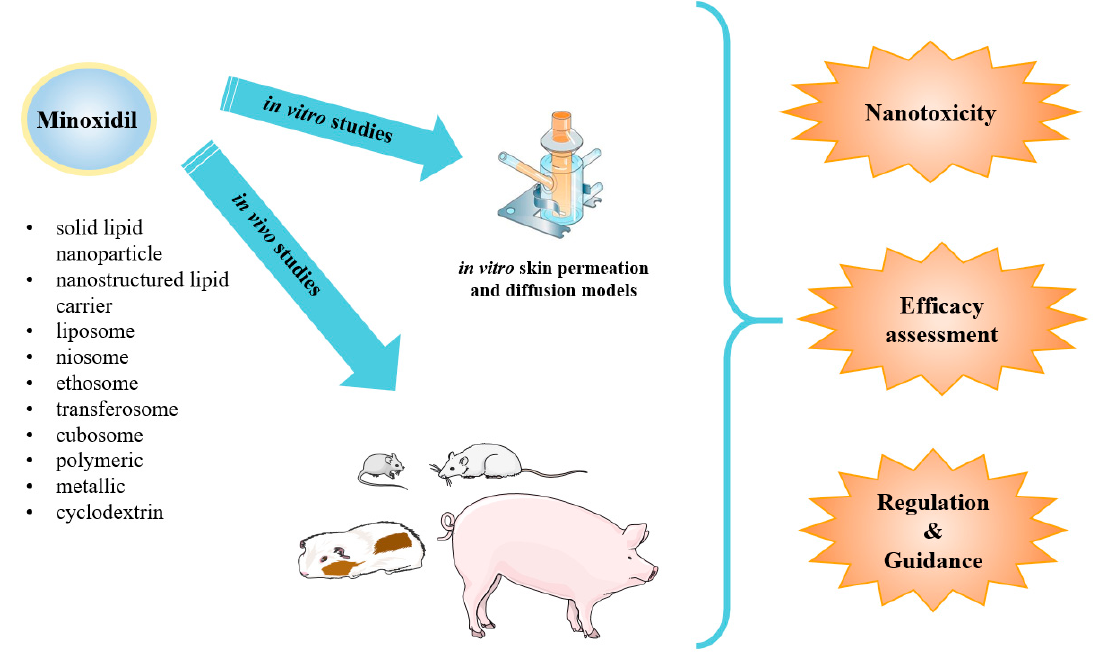
Figure 2. Schematic presentation of minoxidil nanoparticle types applied as topical drug delivery systems for androgenic alopecia developed so far. Such systems have been submitted to in vitro and in vivo studies for toxicity, safety and efficacy profiles assessment under the regulation and guidance applied nowadays.